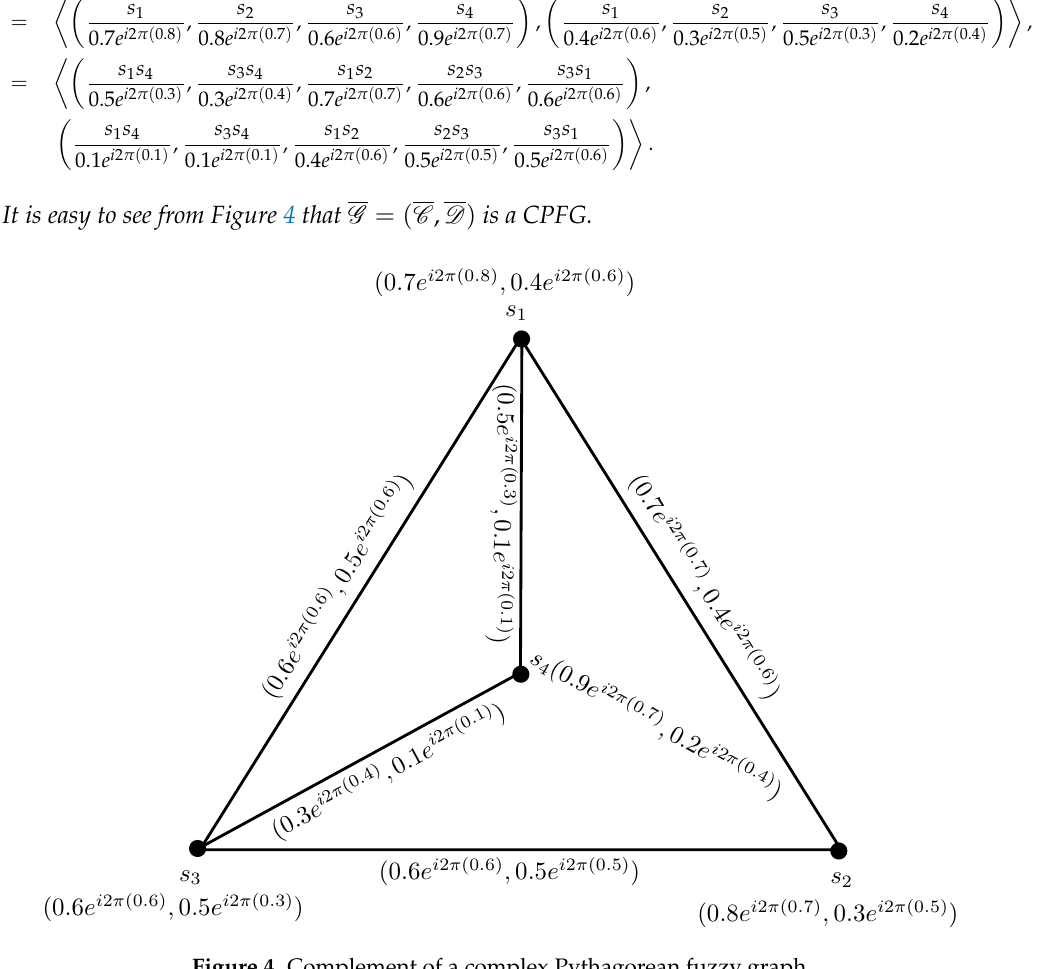
Figure 4. Complement of a complex Pythagorean fuzzy